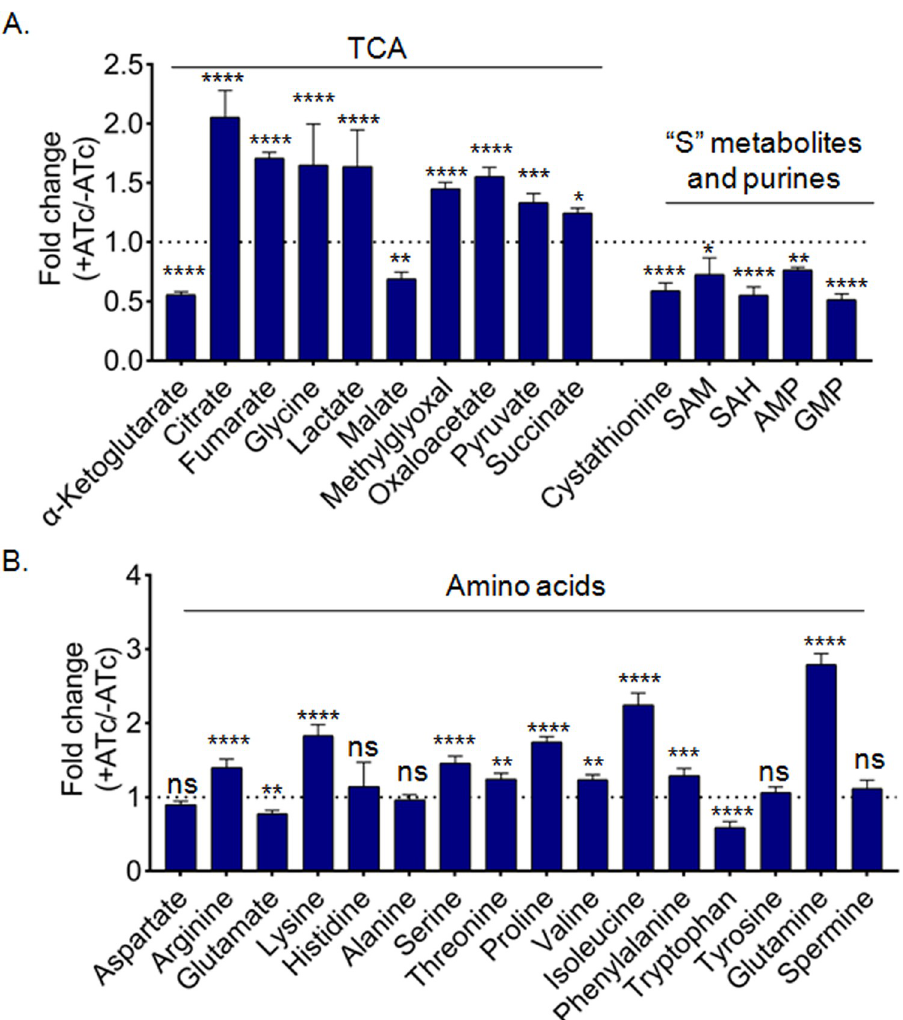
Fig 5. Depletion of SufT results in deregulation of metabolites dependent on Fe-S cluster proteins. Single column based LC MS/MS analysis of (A) OBHA derivatized TCA metabolites, underivatized measurement of purines, SAM, Cystathione (CTH), SAH and (B) Amino acids of SufT-KD strain post 72 h of ATc (200 ng/mL) treatment. Experiments were performed in biological triplicate and p value was calculated by two-way ANOVA